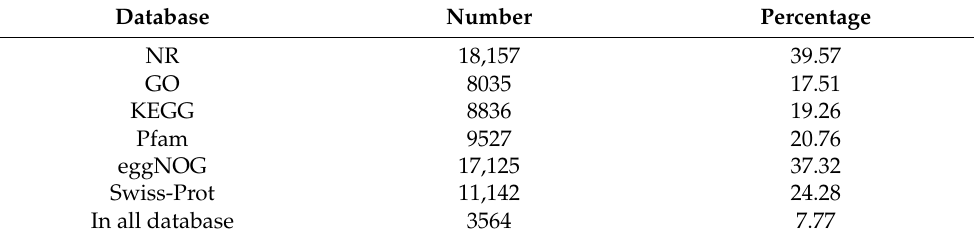
Figure 1. The top 10 species distribution in the NR database. Unigenes were aligned with the NCBI NR protein database. The top 10 species with numbers of matches were shown. Table 1. Functional annotation of unigenes in